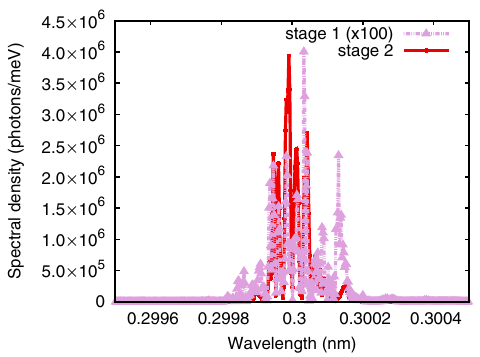
FIG. 18. Pulse energy produced at various wavelengths as a function of distance for the start-to-end bunch.